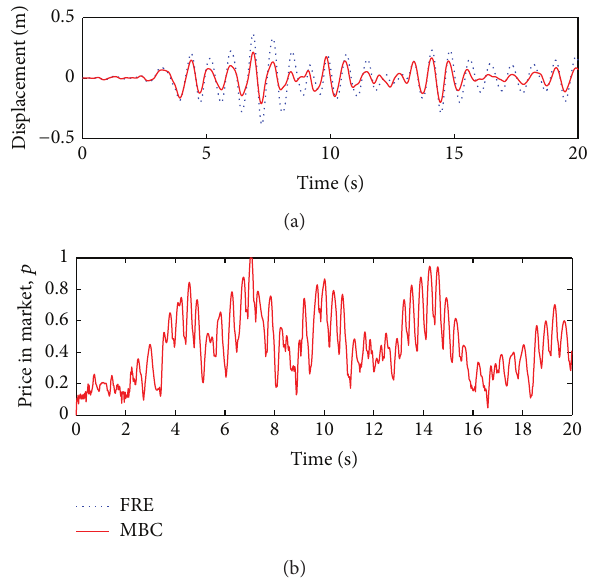
Figure 12: Displacement and price time history of no. 6